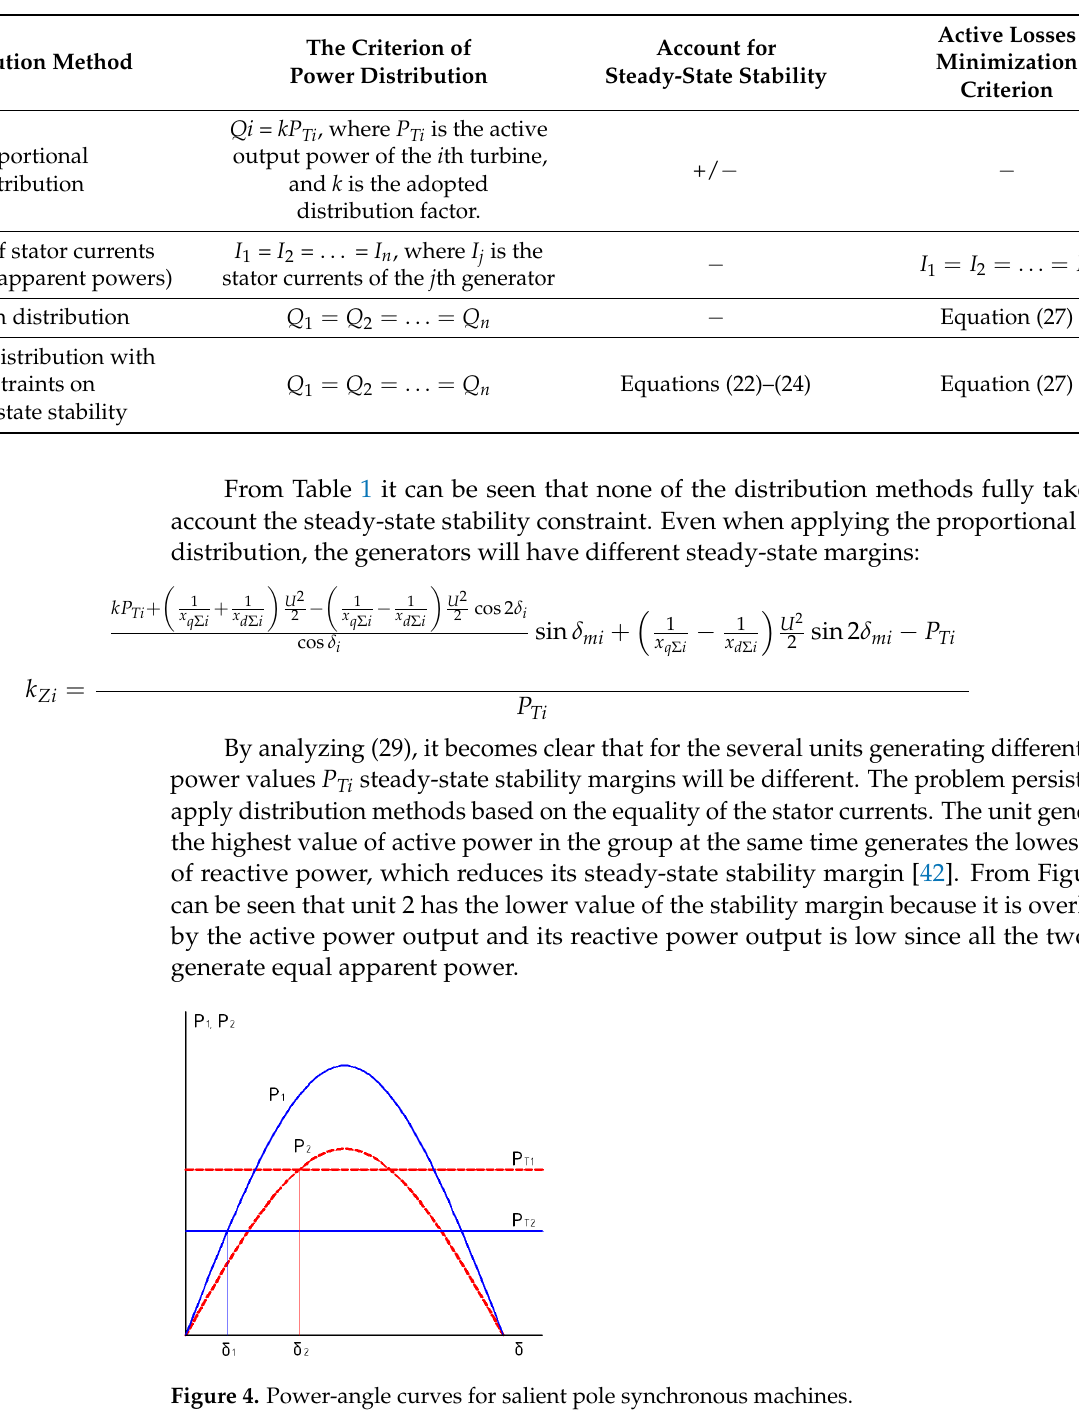
Table 1. Reactive power distribution methods.